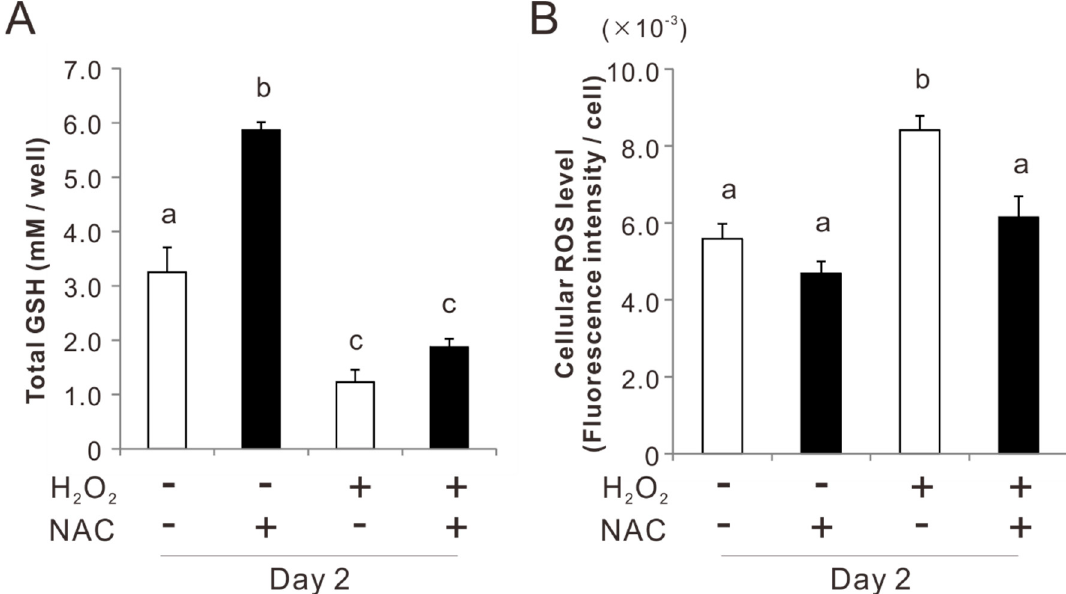
Figure 3. Effects of preconditioning osteoblast-like cells with N -acetyl- L -cysteine (NAC) on cellular redox balance under oxidative stress. Rat femur bone marrow-derived osteoblast-like cells were preincubated with or without 5 mM NAC for 3 h and then cultured in an osteogenic differentiation medium with and without exposure to 50 μ M H 2 O 2 for 2 days. Cellular total glutathione (GSH) levels ( A ) and intracellular reactive oxygen species (ROS) levels ( B ) in each condition were measured by a fluorometric or photometric analysis. The data represent the mean ± standard deviation ( n = 3). Different characters indicate statistically significant differences between them ( p < 0.05, Tukey’s HSD test).